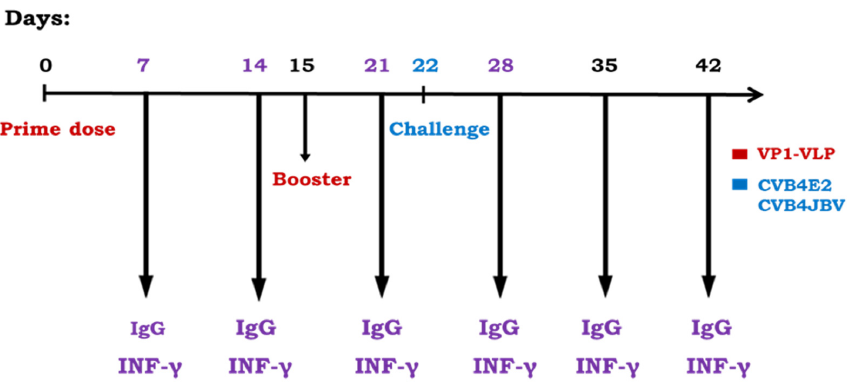
Figure 1. Mice immunization and challenge schedule. Mice Group 1 were intraperitoneally (ip) im- munized with a prime-boost regimen at days 0 and 15. Immunized mice Group 2 and Group 3 were immunized with a prime-boost regimen and then challenged at day 22 successively with CVB4E2 and CVB4JBV strains. Mice Group 4 and Group 5 received PBS at days 0 and 15 and challenged successively with CVB4E2 and CVB4JBV strains. Group 6 mice represent the naive control group receiving only PBS at days 0 and 15. Neutralizing antibody and cytokine titers were measured in serum collected from mice tails at days 7, 14, 21, 28, 35, and 42.